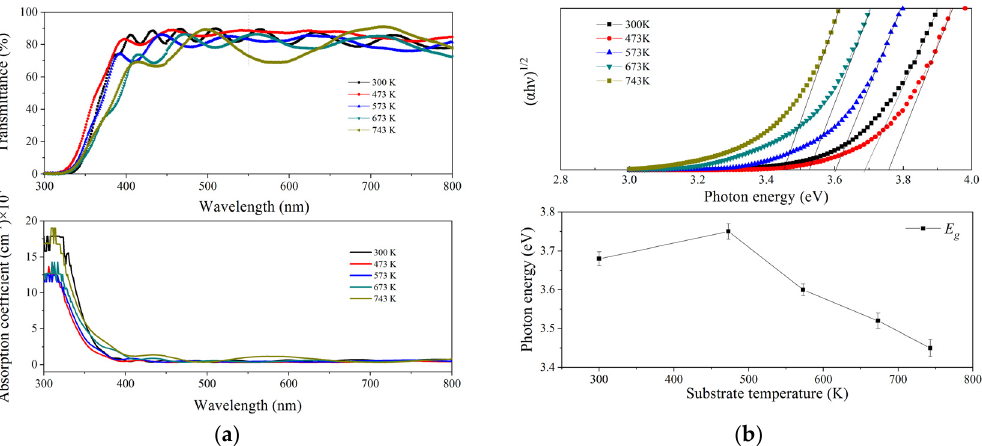
Figure 5. The WO 3 films deposited at different substrate temperature: ( a ) transmittance and absorption coefficient curve and ( b ) Tuac plot and E g curve.